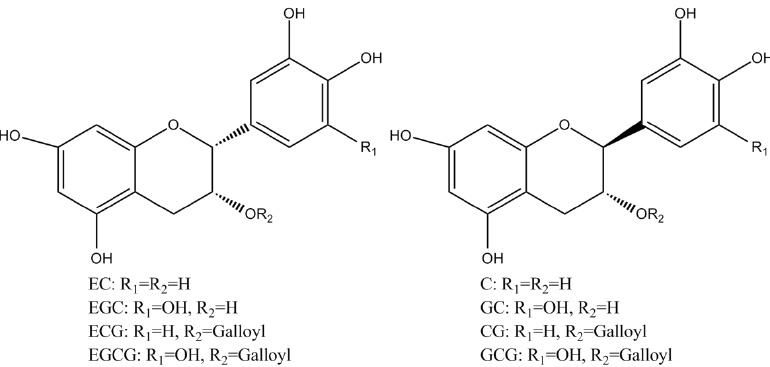
Figure 1. Structures of the major catechins in tea.